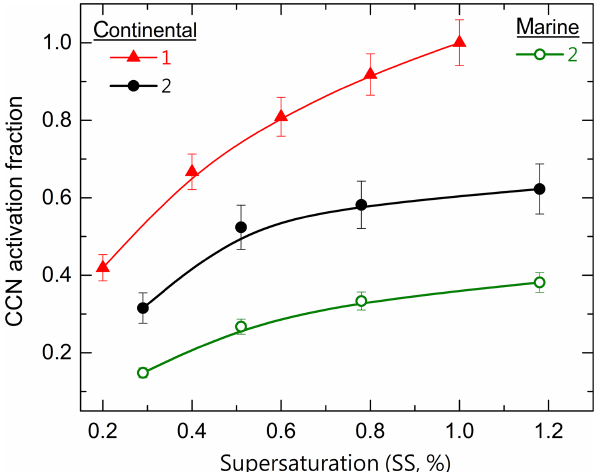
Figure 8. Variation of CCN activation fraction at different SS dur- ing continental and marine (conditions). Vertical error bars indicate the standard